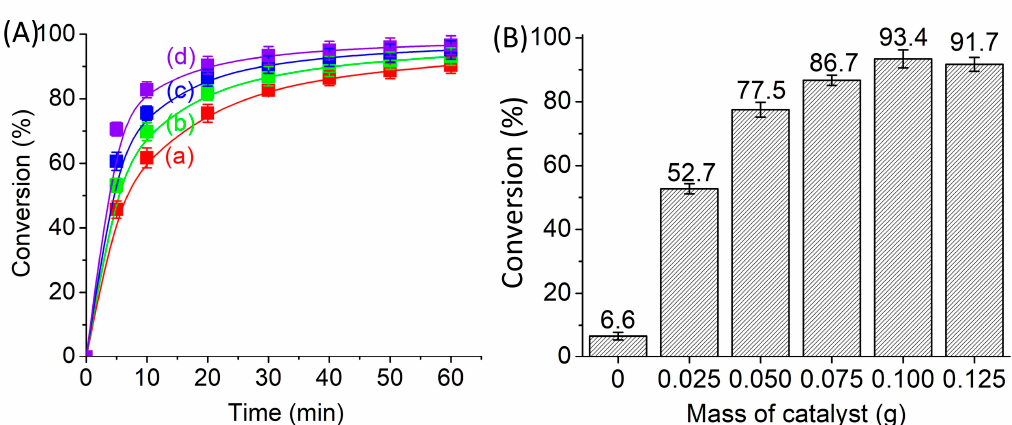
Figure 10. ( A ) Conversion of levulinic acid via esterification enhanced by SAPO-11 (E-3) catalyst at (a) 150 ◦ C, (b) 160 ◦ C, (c) 170 ◦ C and (d) 180 ◦ C under conductive instant heating using reaction conditions: m SAPO-11 = 0.100 g, levulinic acid:ethanol ratio = 1:11, and ( B ) effect of catalyst